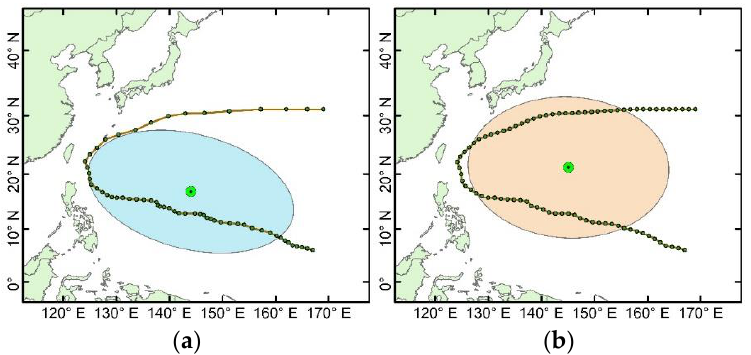
Figure 8. Central point and variance ellipse of the trajectory obtained by the ( a ) original trajectory points and ( b ) equal division trajectory points for Typhoon Emma (November 1959).